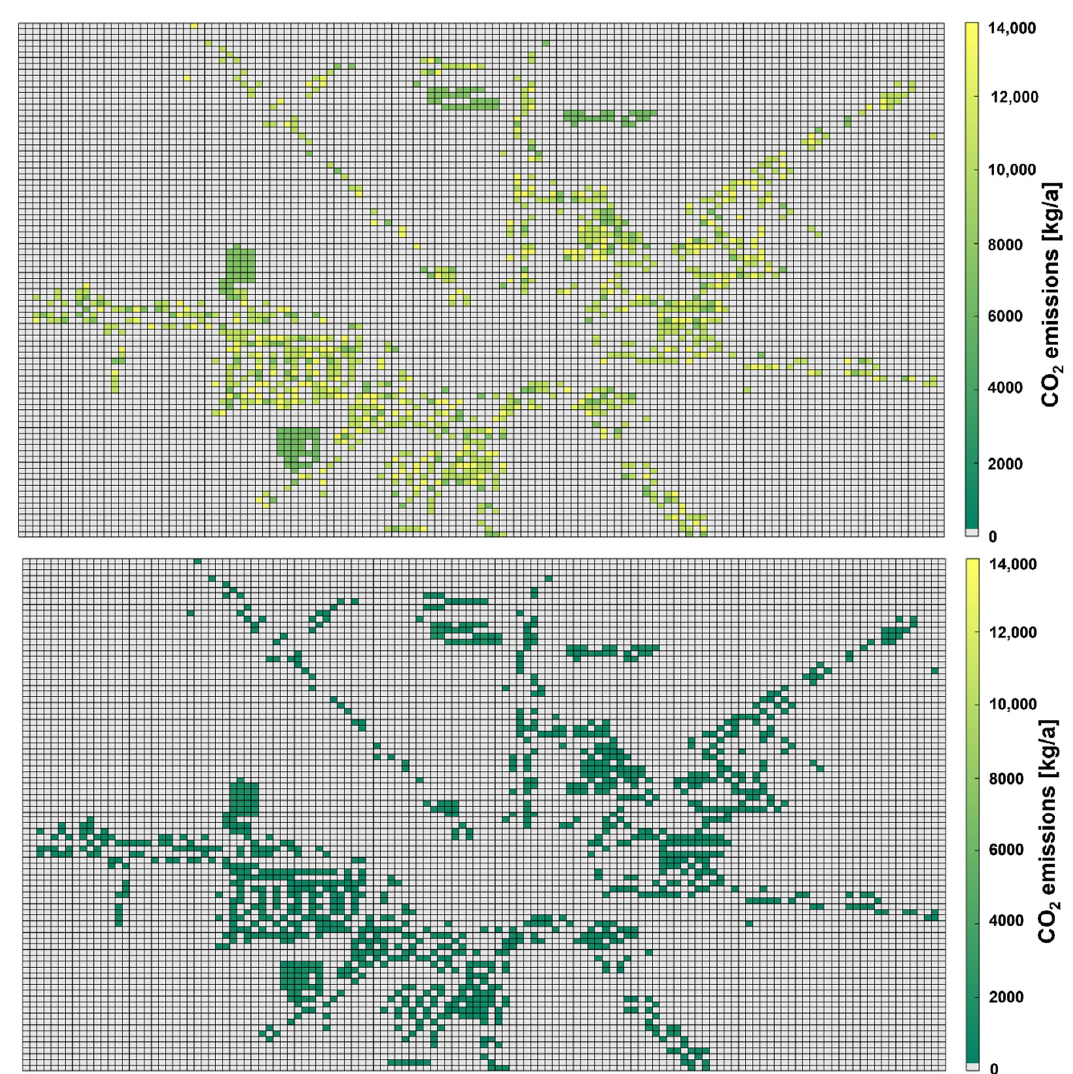
Figure 7. CO 2 emission maps for the Nowosolna cluster for the V0 (up) and V3b (down) scenarios. The considered PVs are highly efficient ones, with the efficiency of 21% (280 Wp each); the total area of 25,028.85 m 2 of PVs is assumed (the V2a variant). The considered system is examined as on ‐ grid; thus, it is possible to transfer the surplus electricity generated to the grid. All of the PVs can produce up to 3606.20 MWh/a electricity, with a peak productivity of 4.19 MWp. The map of solar energy potential is shown in Figure 8; the examined neighborhood could be considered as a solar cluster whenever so many PVs are applied. The usage of wind energy is examined in two cases, for VAWT and HAWT, where results for the home applied turbines are assigned as V2b. The technical parameter of the examined turbines is considered following their technical documentation, 3.0 kW for the VAWT and 1.6 MW for the HAWT. Only two HAWTs are required to cover the peak demands; nevertheless, it covers the electricity demand of the cluster for approximately 37% of the time (3183 h). The usage of VAWT is not efficient; the application of singular turbines for each house provides a 14% reduction (saving of 1108.44 MWh) in the electricity demand of the cluster. A summary of the RES calculations is shown in Table 5. Due to the fact that the wind energy application is not so efficient for the Lodz localization, considering both the energy and economic aspects, only the V2a scenario is used in further analysis (as a basis for the V3a and V3b variants). Table 5. Application of RES (in MWh/a) in the Nowosolna cluster—summary. Produced